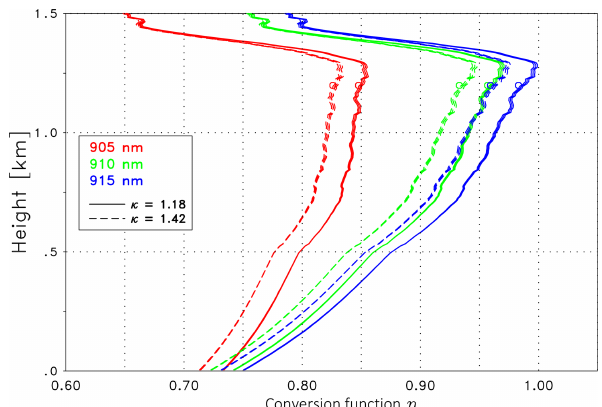
Figure 5. Conversion function η at 905nm (red), 910nm (green) and 915 nm (blue) for Case A; κ is assumed to be constant with height. The solid lines are for κ = 1 . 18; the dashed lines are for κ = 1 . 42. The three lines grouping together refer to different lidar ratios, with the smallest ( S p = 45sr) marked with a